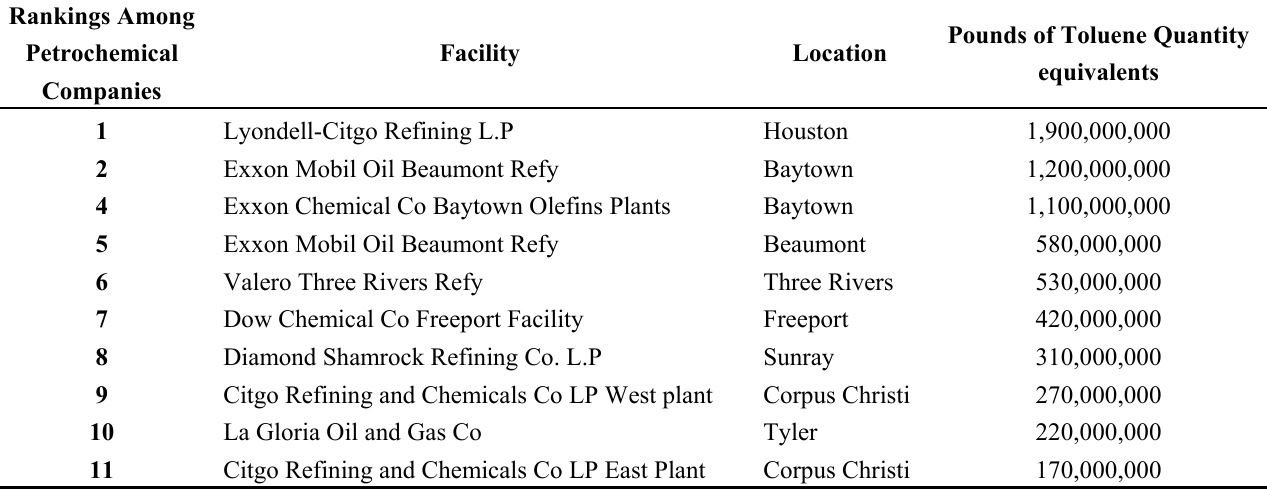
Table 10. Facilities Contributing to Non-cancer